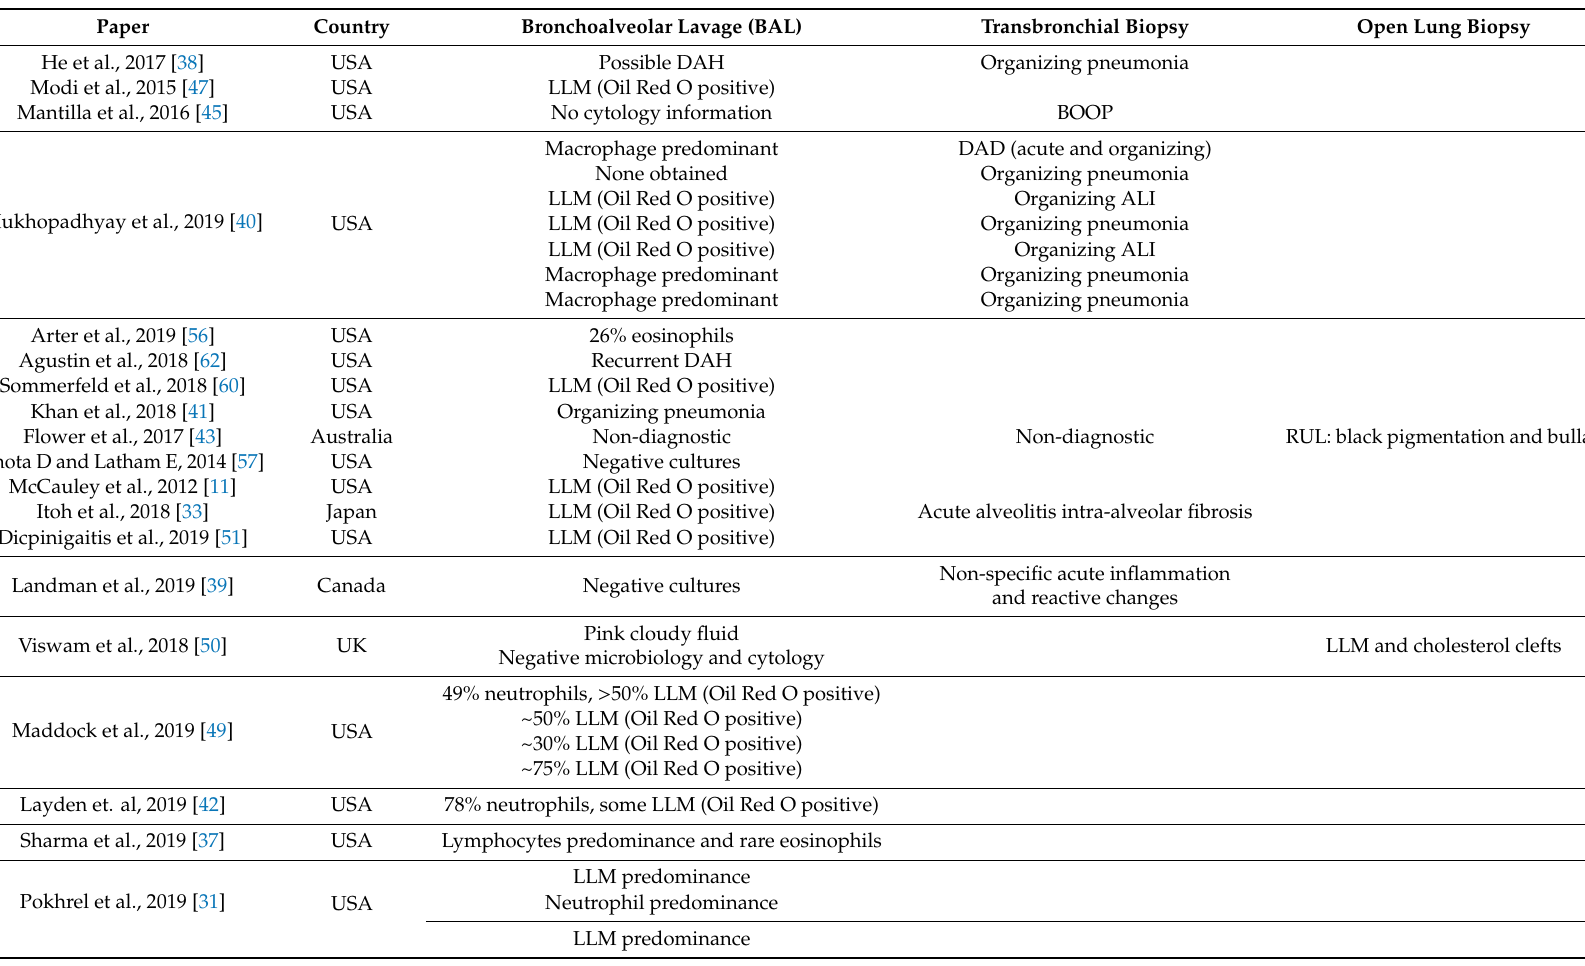
Table 3. Publications of e-cigarette case reports with cytologic and histologic